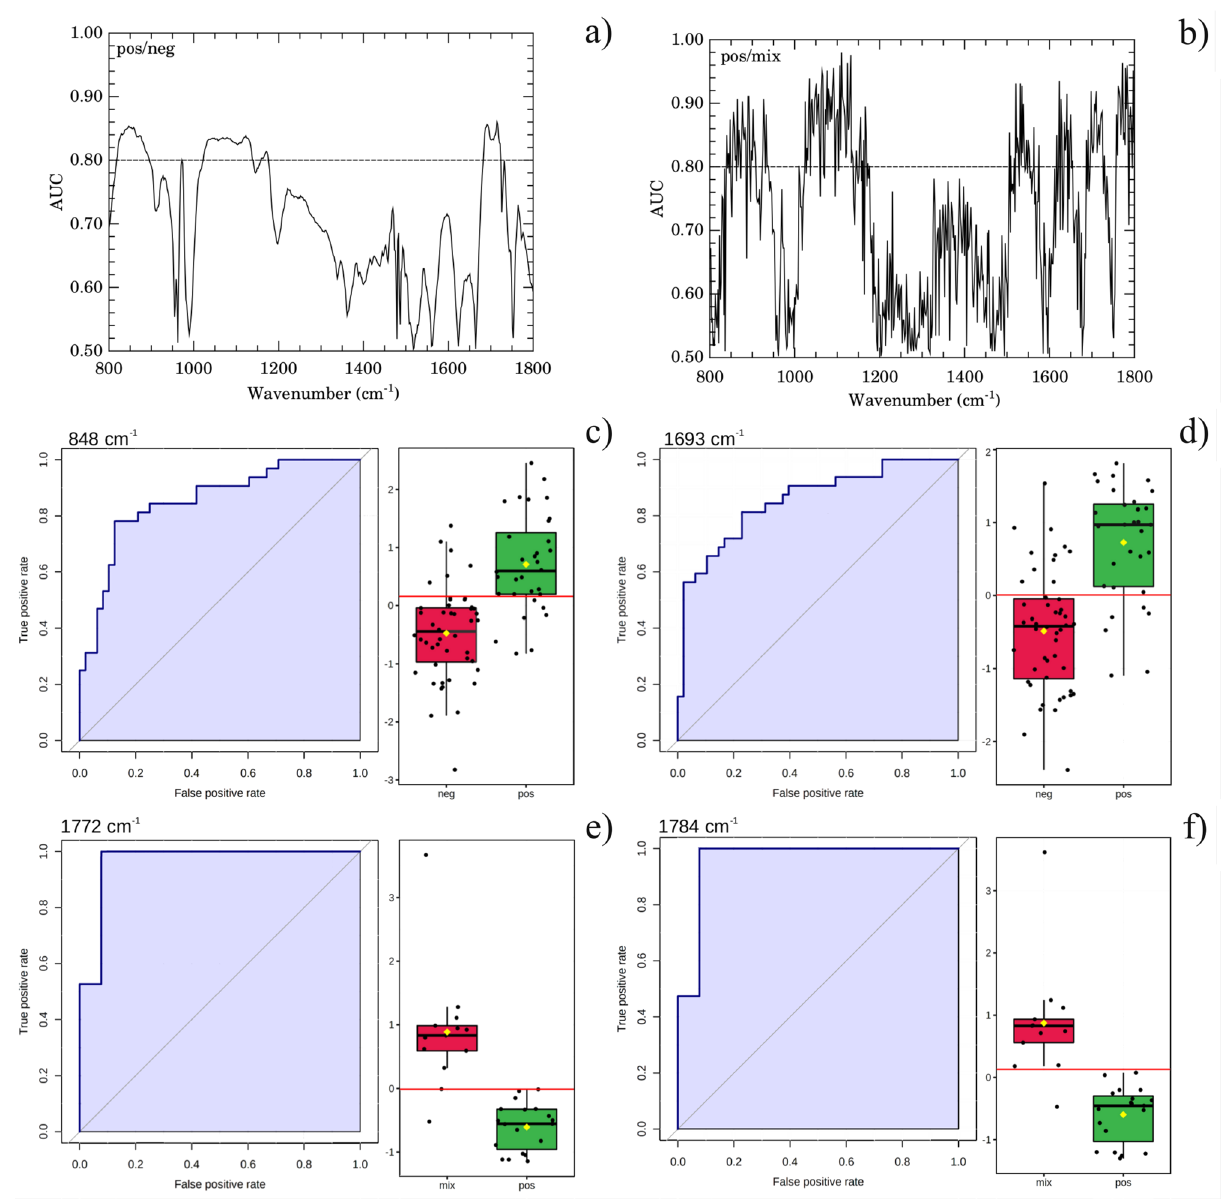
Figure 7. Diagnostic performance of micro-FTIR. Area under receiver operating characteristic ( AUC ) against wavenumber showing those bands with excellent discriminating power ( AUC > 0.80 , dashed horizontal line) for positive/negative ( a ) and positive/mix ( b ) classes. Selected representative curves of receiver operating characteristic (ROC) and corresponding classification box-plot of the intensity of the left-handed helix DNA (Z 1 form) ( 848 cm − , c ), β -sheet structure of Amide I of proteins ( 1693cm − 1 and 1784 cm − in ( e , f ), respectively) bands. The horizontal red line is the threshold for